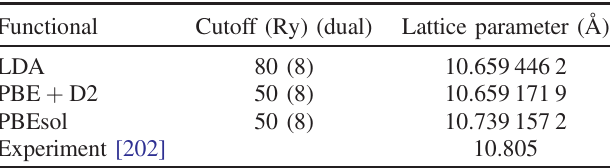
TABLE II. Lattice parameters of La 2 Zr 2 O 7 (cubic) obtained by first-principles simulations or experiments [202]. A 4 × 4 × 4 mesh of k points with a ( 1 × 1 × 1 ) shift is used.